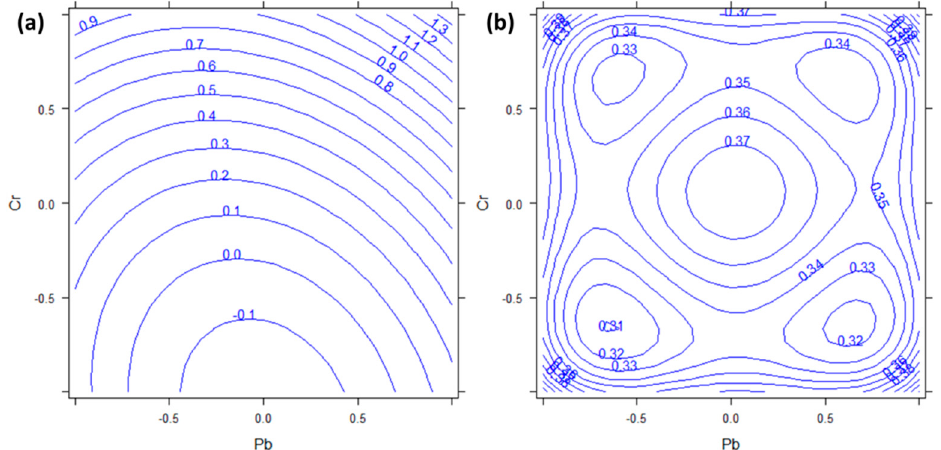
Figure 2. ( a ) Response surface and ( b ) semiamplitude of the 95% confidence interval for Cr response. Factors Cr and Pb are reported in abscissa and ordinate respectively. Cd has been kept constant to the 0 level.